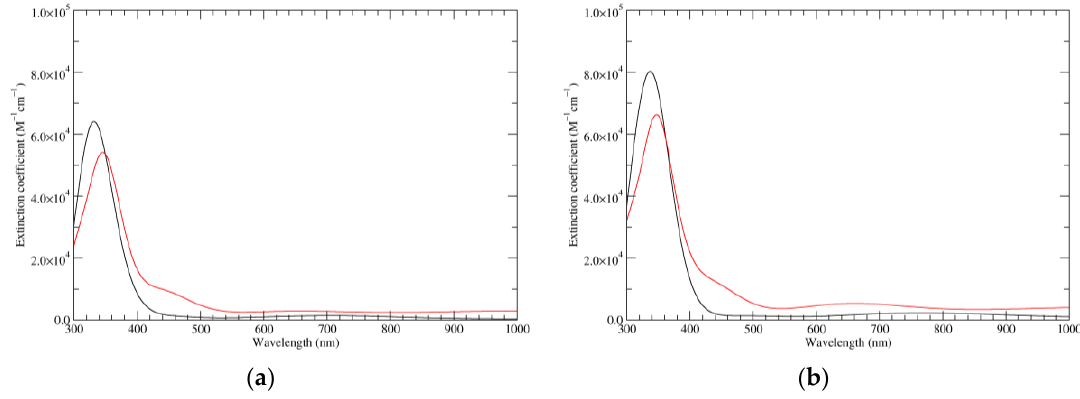
Figure 3. Computed UV–Vis spectra of the most significant tautomers/conformers in the one-electron oxidation state. ( a ) Neutral form in vacuo: black line, a5_b0_c0_d0, C 1 , conf1; red line, a6_b0_c0_d0, C 1 , conf1. ( b ) Neutral form in water: black line, a5_b0_c0_d0, C 1 , conf1; red line, a6_b0_c0_d0 C 1 , conf1.